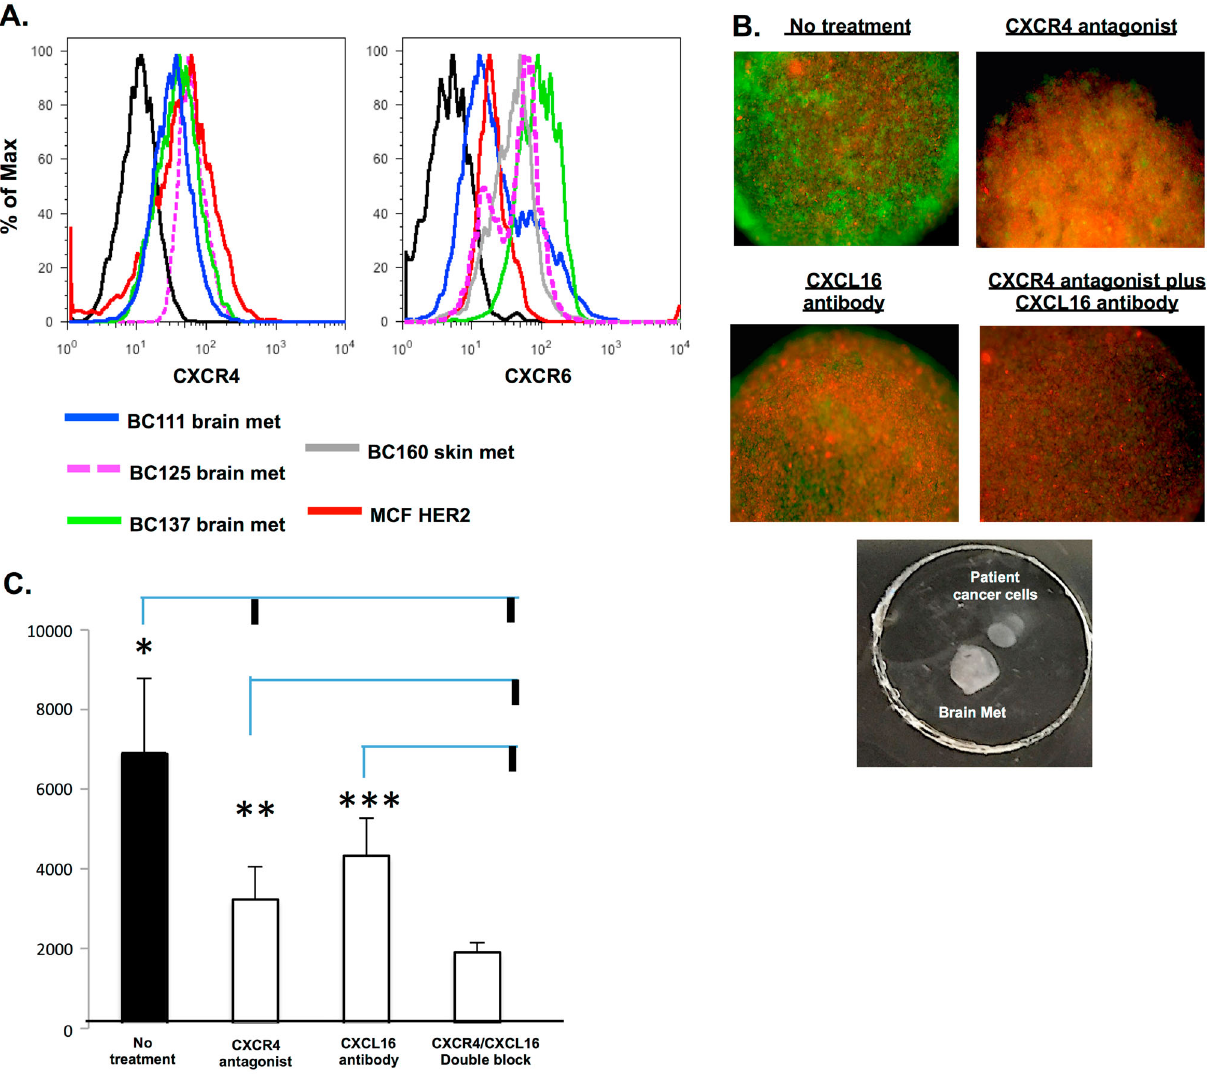
Fig. 5 Combination of CXCR4 antagonist and CXCL16 neutralizing antibody treatment reduces cancer cell recruitment. a FACS analysis of relative CXCR4 or CXCR6 expression on cancer cell line MCF HER2 and patient-speci fi c cancer cells derived from brain metastasis or skin metastasis tissue. b Immuno- fl uorescent images demonstrate relative migration of patient-speci fi c cancer cells ( green ) to brain metastasis stroma ( red ) with or without CXCR4 antagonist and CXCL16 neutralization in Hydrogel-Migration assay. c : Bar graph quanti fi es the relative migration of patient speci fi c cancer cells that have been untreated or treated with CXCR4 antagonist, CXCL16 neutralization antibody, or a combination of both agents. An asterisk indicates signi fi cant differences between groups of animals (* P ≤ 0.02, ** P ≤ 0.045, *** P ≤ 0.02). Each value represents the mean of 3 – 5 independent experiments. For the migration assay, BC25, BC55, BC66, BC70 brain metastatic CAF aggregates were independently utilized ( see Table 1). Consistent results were obtained in repeated experiments throughout. The vertical bold lines branching off from the top of the horizontal lines represent statistically signi fi cant P values when the untreated, CXCR4 antagonist, and CXCL16 neutralizing antibody groups were individually compared with all other